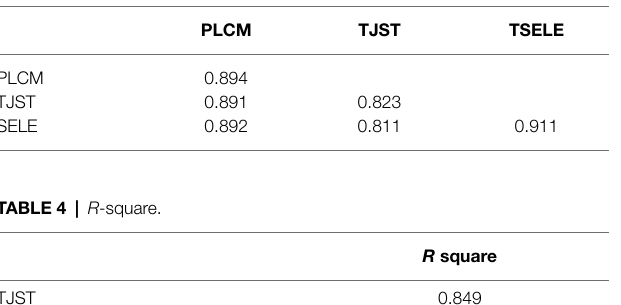
TABLE 1 | Cross loadings.